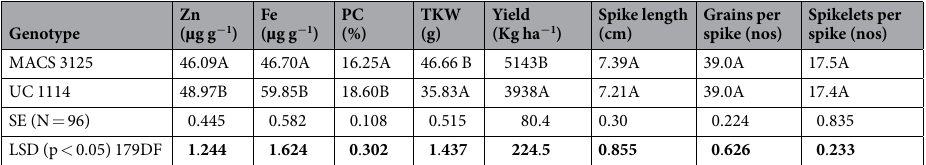
Table 3. Response of the genotypes to the various foliar treatments with respect to grain characteristics. Values indicate means of 6 treatments × 4 replicates × 4 independent yearly trials. Means with the same letter are similar at 5% significance level using Fischer’s LSD. LSD values are in bold font to differentiate from data values. PC denotes protein content; TKW denotes thousand kernel weight.